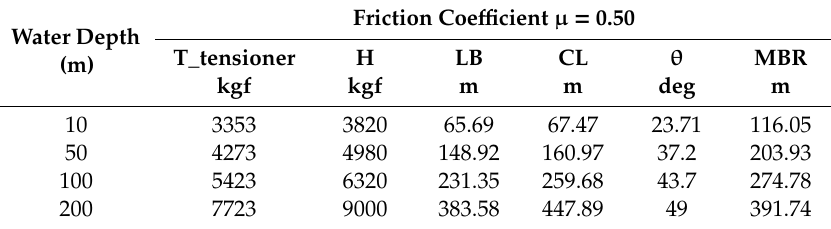
Table 10. Cable critical responses assuming friction coe ffi cient µ = 0.50.